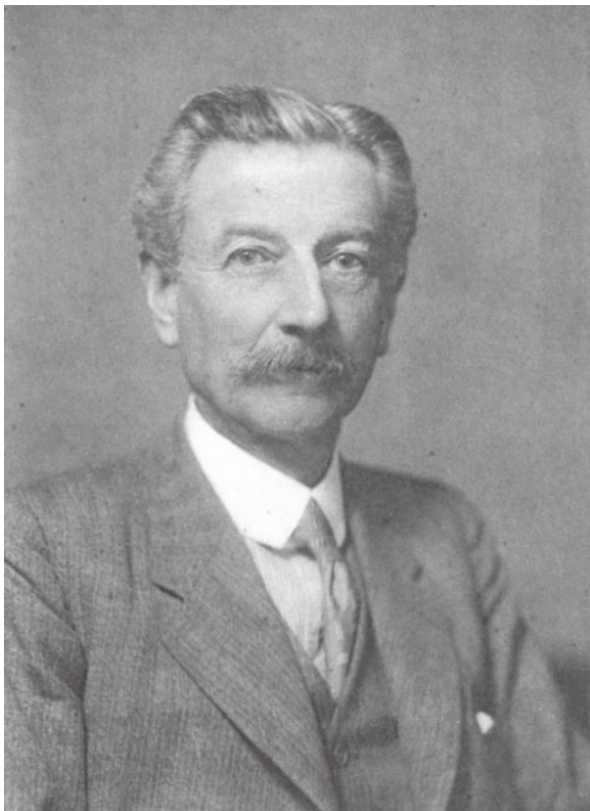
Figure 11. Arthur George Green (1864-1941) ( Obit. Notices Fellows R. Soc . 1943, 4, 251–270; courtesy of